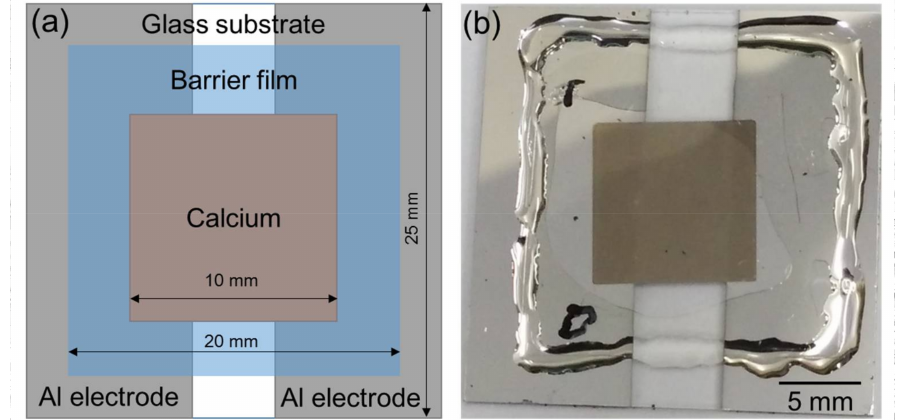
Figure 4. ( a ) Schematic diagram of Ca-sensor layout for WVTR measurement of barrier film; ( b ) Photograph of the WVTR sample and Ca-sensor